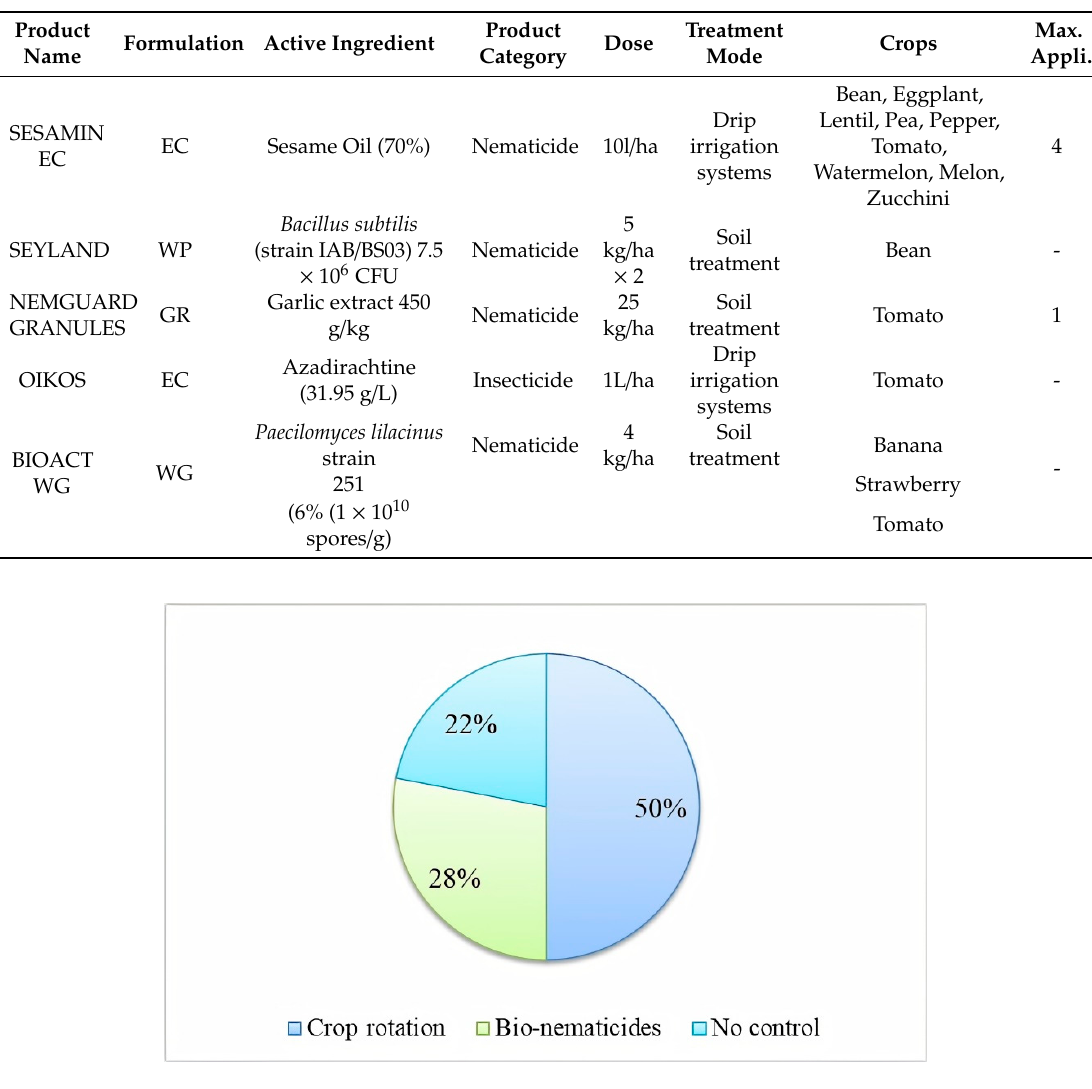
Figure 8. Control measures for nematodes adopted by organic farmers in most organic farming systems in Souss-Massa Morocco.